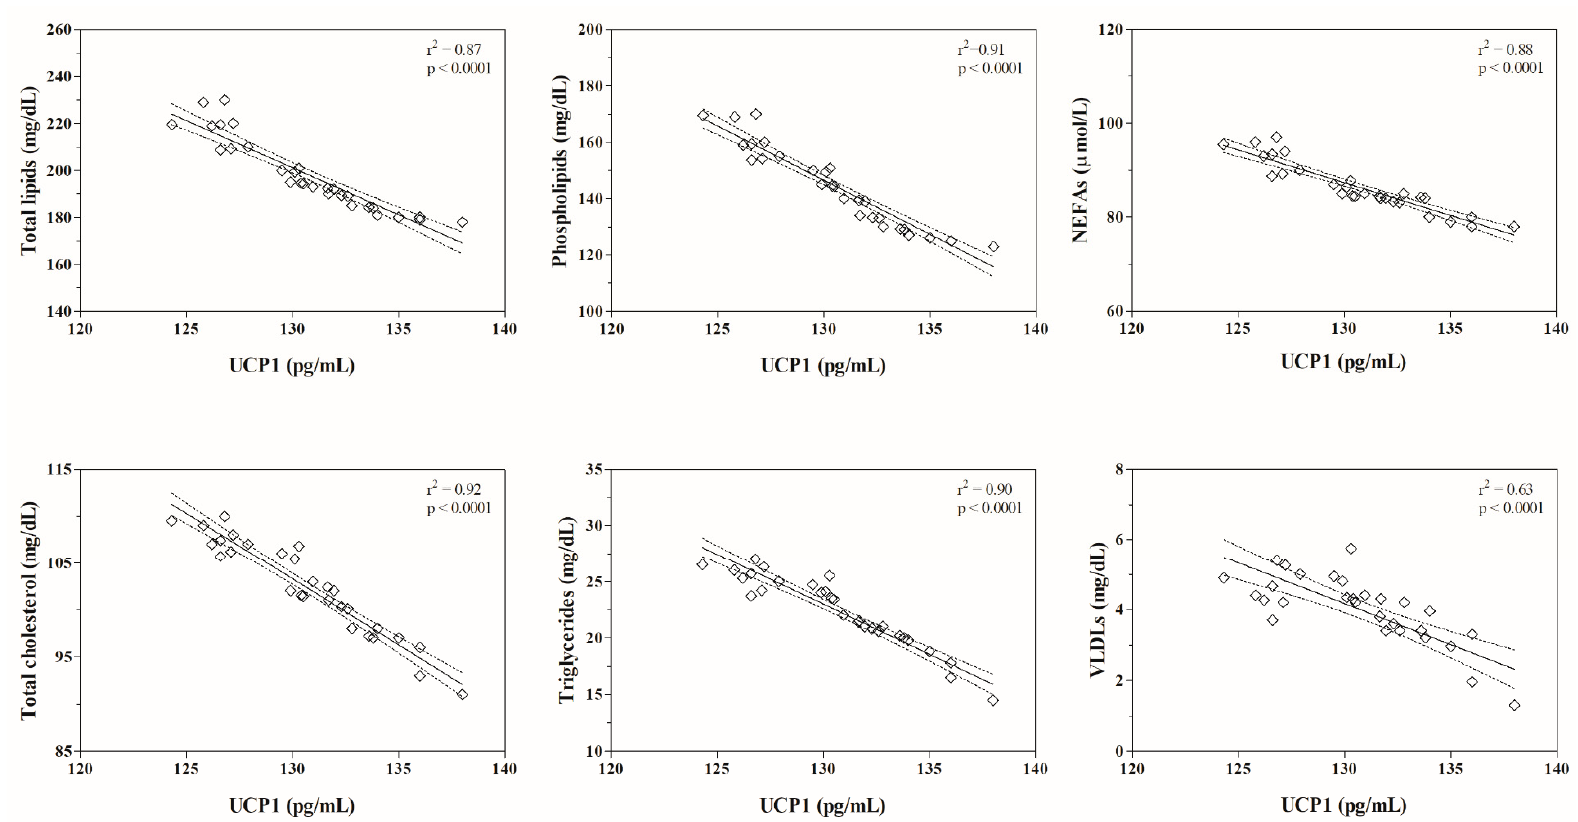
Figure 2. Results of linear regression model between the serum values of mitochondrial uncoupling protein-1 (UCP1) and the serum levels of lipid and lipoprotein indices obtained in investigated horses.